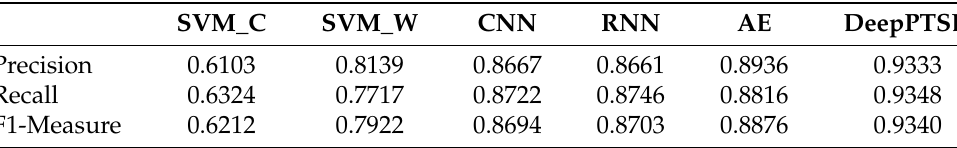
Table 5. The evaluation of the payload data augmentation